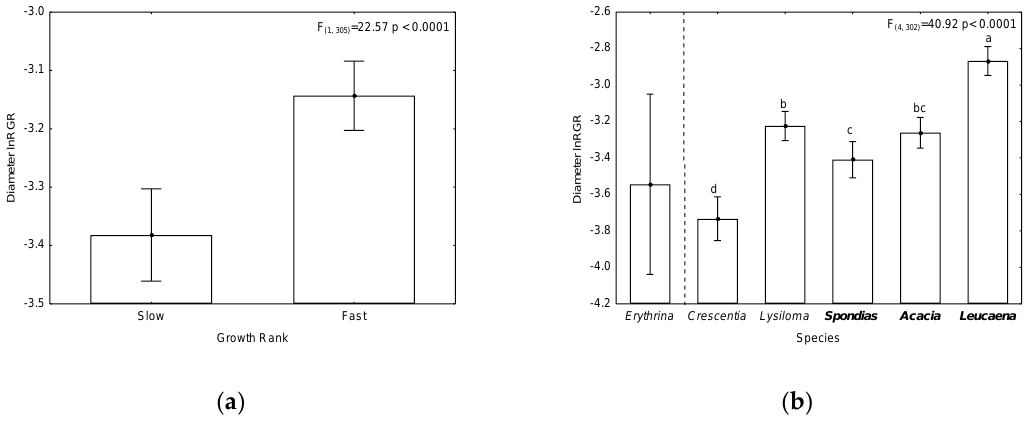
Figure 4. Forty months’ diameter lnRGR of slow- ( n = 2) and fast- ( n = 3) growing species (a) and six tree species (b) growing in fenced plots at Quilamula, Morelos, Mexico. Diameter lnRGR for Erythrina americana is shown but this species was removed from RGR analysis due to low survival. Different letters show significant differences evaluated with Tukey test. Genera of fast-growing species are shown in bold.